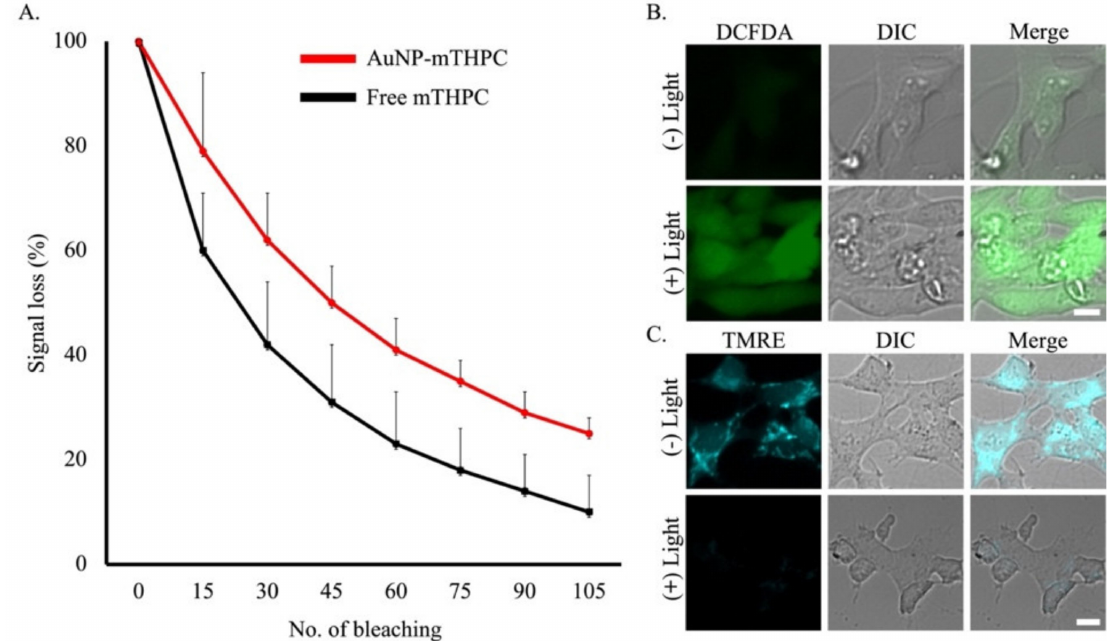
Figure 4. Photostability of AuNP–mTHPC and induced reactive oxygen species (ROS) that decreases mitochondrial membrane potential ( ∆ ψ m ) after PDT. ( A ) Signal loss (%) of fluorescent emission of free mTHPC and AuNP–mTHPC with the increasing number of bleaching iterations. Excitation wavelength: 561 nm for free mTHPC and AuNP–mTHPC. The average quantification of three repeated experiments is presented in the plot (mean ± STDEV). ( B ) Images of SH-SY5Y cells incubated with the ROS-reactive dye DCFH-DA to measure the level of ROS. Green fluorescence signal indicates the presence of DCF oxidized from DCFH. Detection of intracellular ROS production by DCFDA in SH-SY5Y cells after incubation with 1.2 µ M of AuNP–mTHPC, with or without 650-nm light irradiation (6 mW/cm 2 , 4 min). Scale bar = 10 µ m. ( C ) Images of SH-SY5Y cells incubated with the TMRE to evaluate mitochondrial membrane potential ( ∆ ψ m ). Cyan fluorescence signal indicates mitochondrial membrane activity. Detection of intracellular mitochondrial membrane activity by TMRE in SH-SY5Y cells after incubation with 1.2 µ M of AuNP–mTHPC, with or without 650-nm light irradiation (6 mW/cm 2 , 4 min). Scale bar = 10 µ